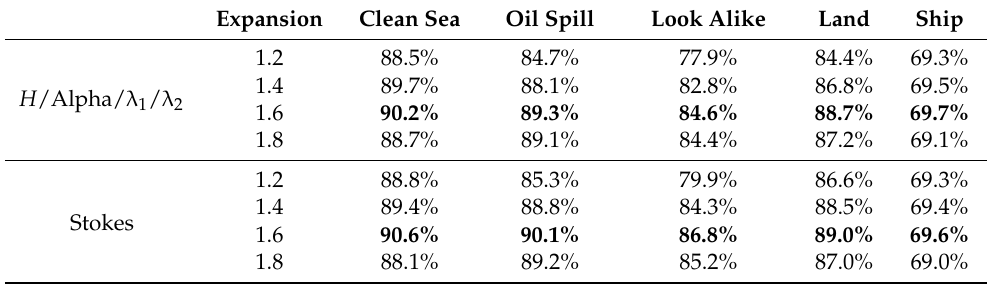
Table 11. IoU Values of polarized parameters with 125 × 125 superpixels and different expansion coefficients.